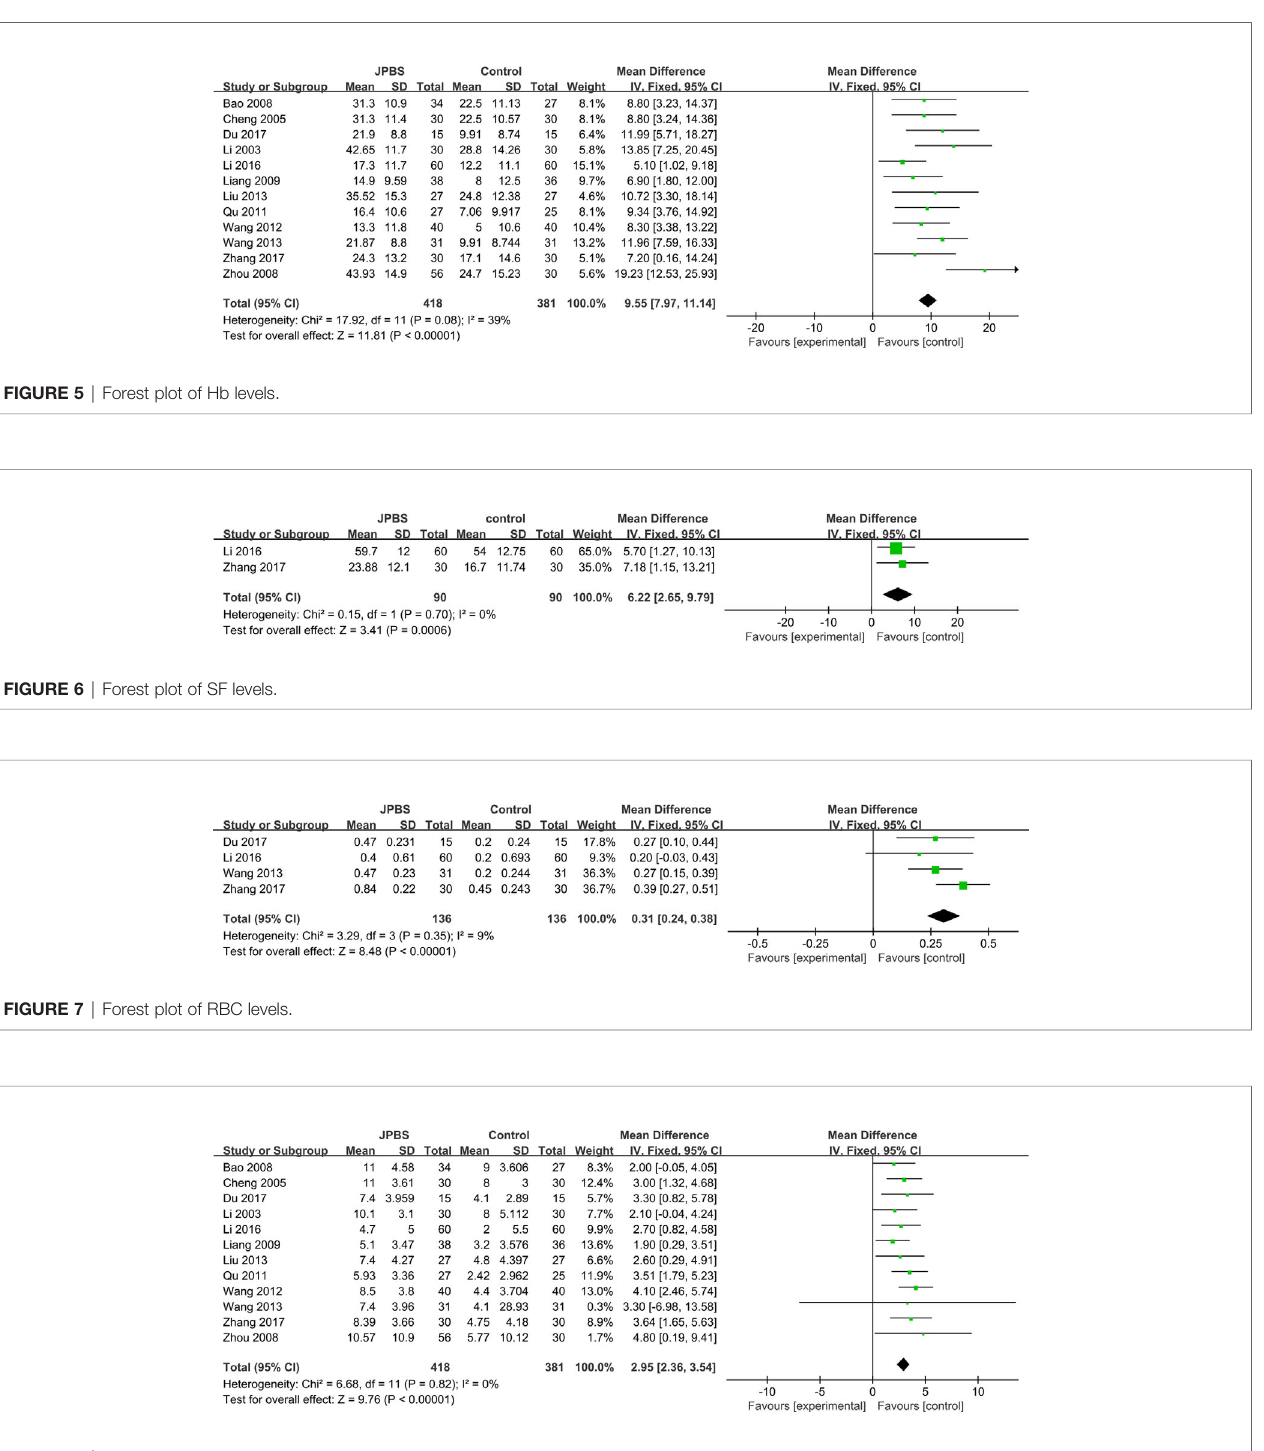
FIGURE 8 | Forest plot of HCT